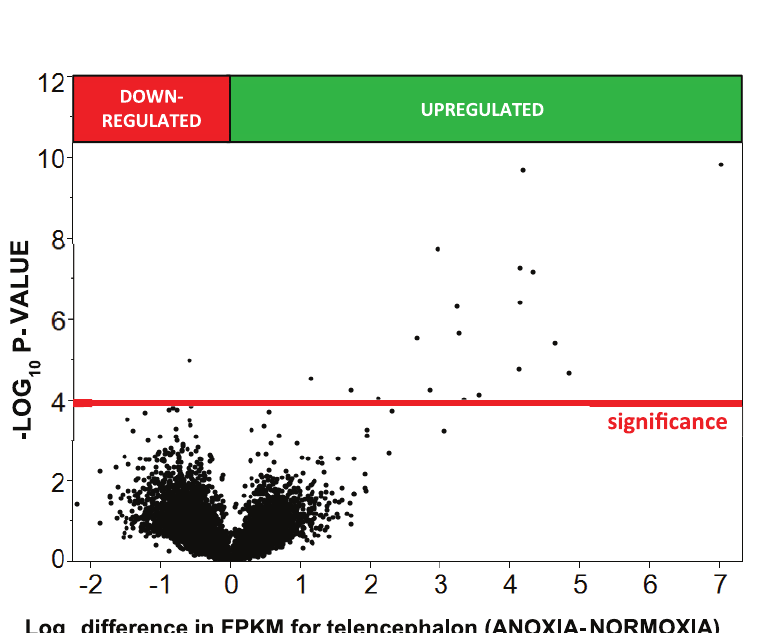
Fig 3. Volcano-plot showing transcriptomic changes in telencephalon after 24 hours of anoxia at 19°C. The y-axis represents the − log10 of the P-value while the x-axis represents the log2 differential expression for each gene. Differential expression was determined using ANOVA assuming a log-normal distribution. The red reference line represents the significance threshold calculated from the FPR multiple testing